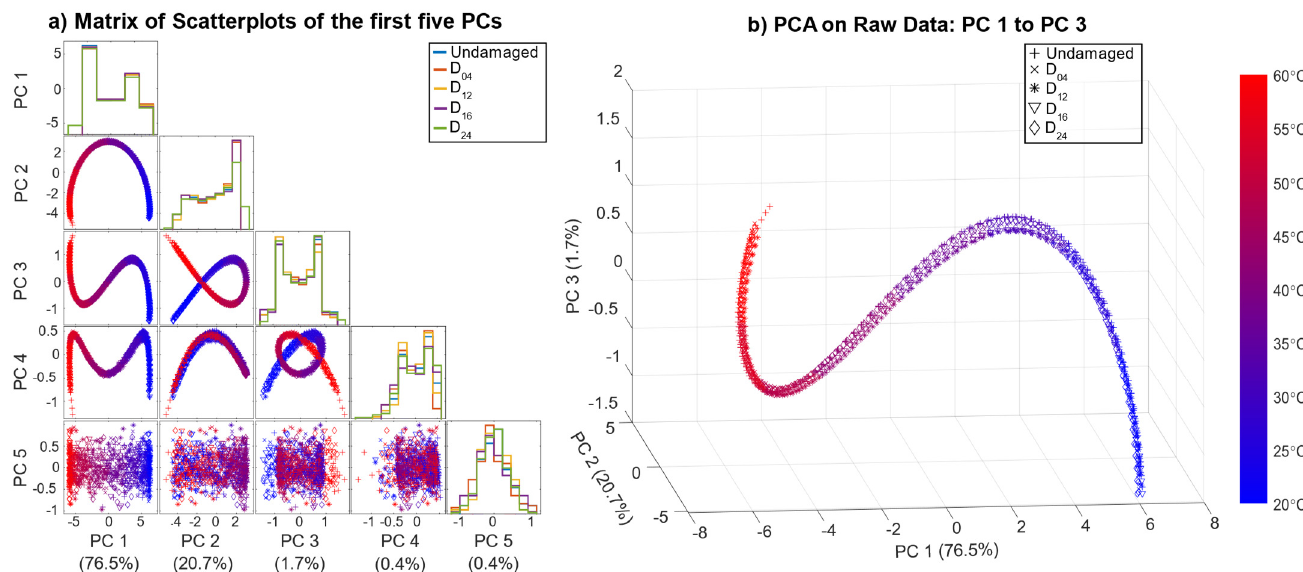
Figure A1. ( a ) Matrix of the first five PCs of the PCA on the raw data (undamaged plate and all simulated damage locations) coloured by their corresponding temperature with their histograms on the diagonal and the variance explained by each PC given as percentage in brackets. ( b ) First three PCs plotted into a three-dimensional space.